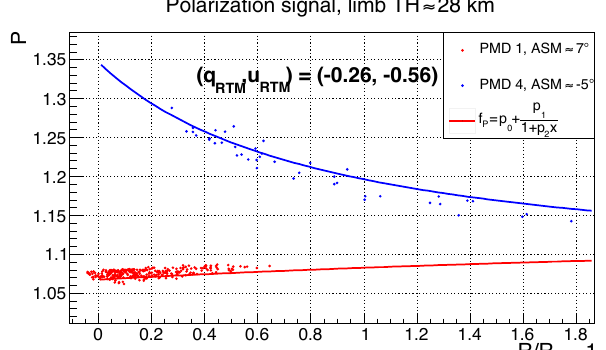
Figure 3. Examples for the extrapolation method for limb, for a fixed cell of (q RTM ,u RTM ) . Blue points are for PMD 4, and red points are for PMD 1; the corresponding curves show the fitted